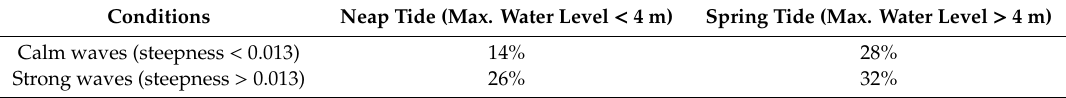
Table 3. Occurrence of hydrodynamic conditions; calm vs. strong waves and neap vs. spring tide.